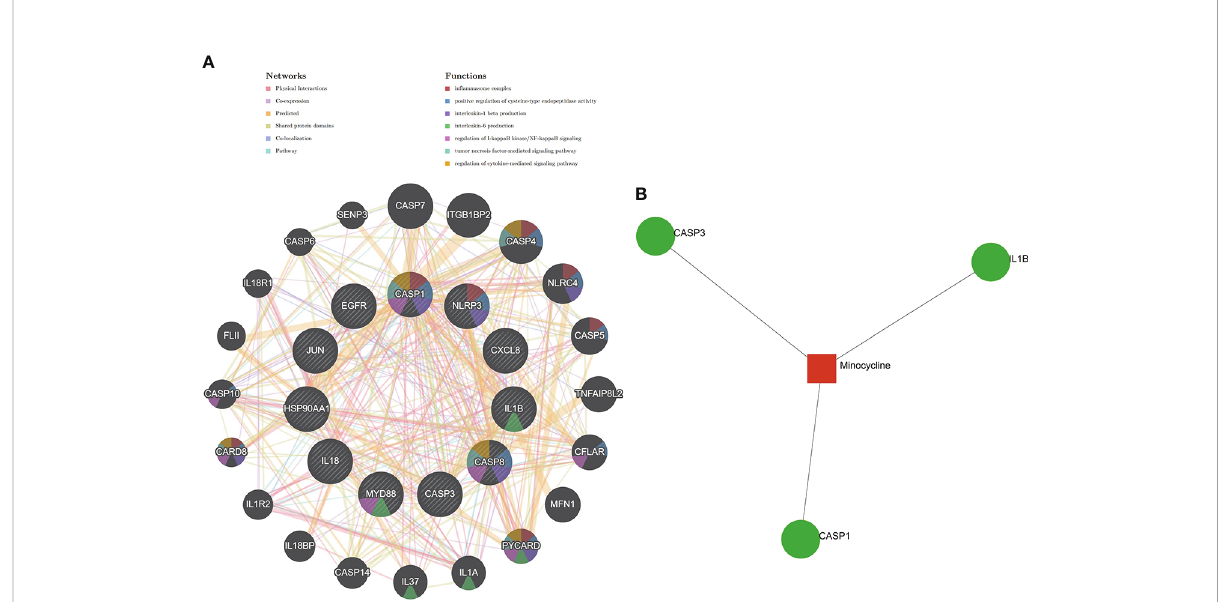
FIGURE 8 GeneMANIA and NetworkAnalyst analysis of Hub genes. (A) The GeneMANIA database examined the gene-gene interaction network of the top 11 hub genes and the 20 most nearby genes. Each node represents a gene. The color of the node links shows the relationship between the relevant genes. (B) Results for the top 11 Hub genes by NetworkAnalyst ’ s Protein-Drug Interaction Function (DrugBank database 5.0). Drugs were in red and target genes were in